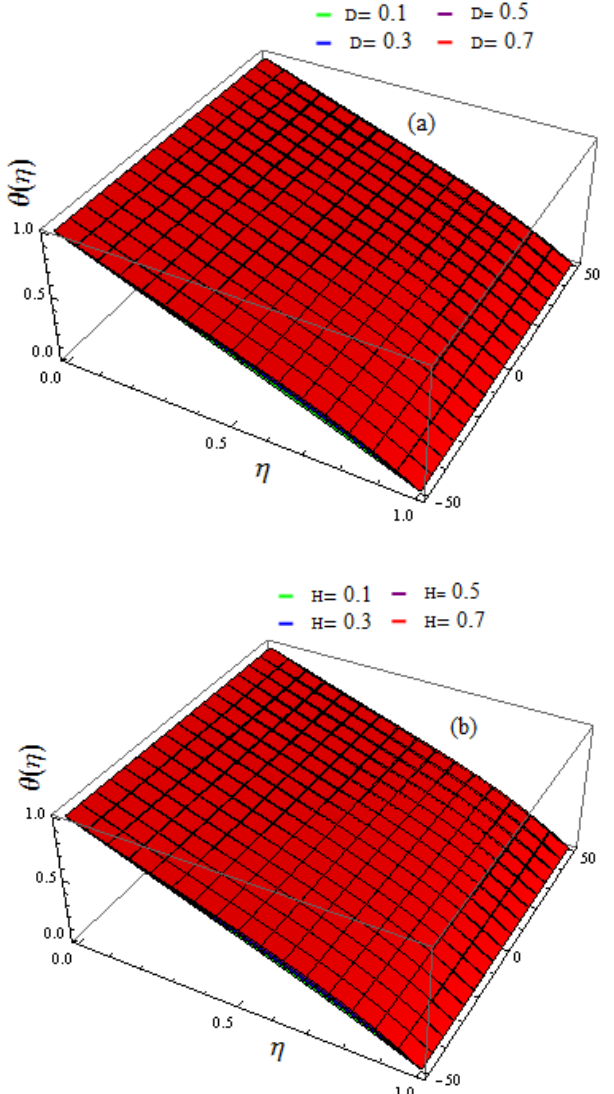
Figure 14. ( a ) Impact of D > 0. ( b ) H > 0 on θ ( η )